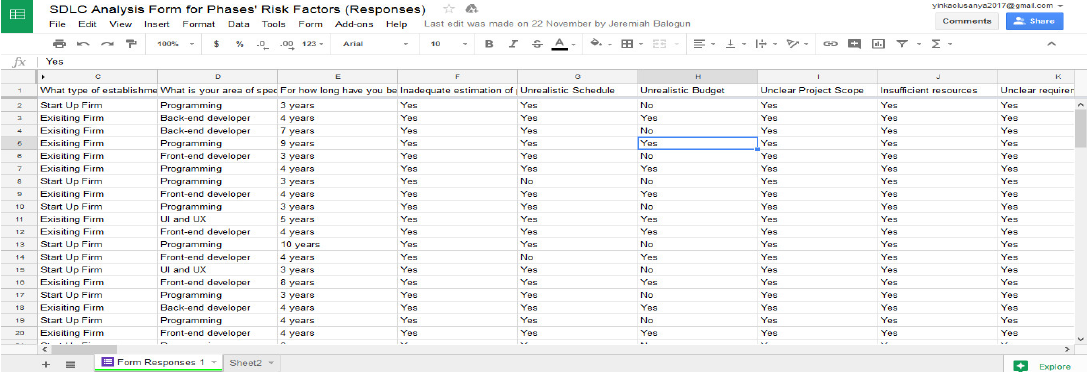
Figure 3. Responses to administered questionnaires via Google Forms.